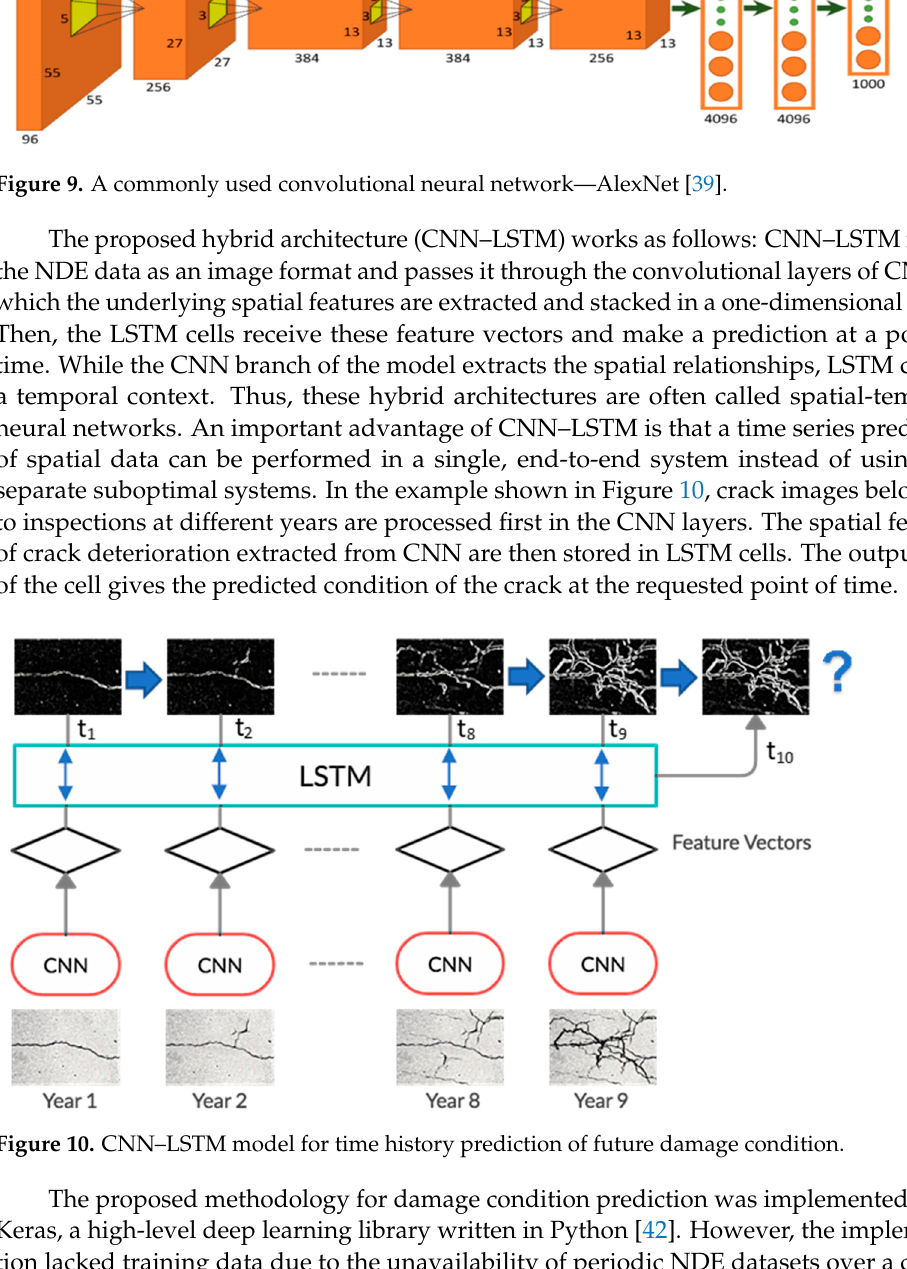
Figure 9. A commonly used convolutional neural network—AlexNet [39] .